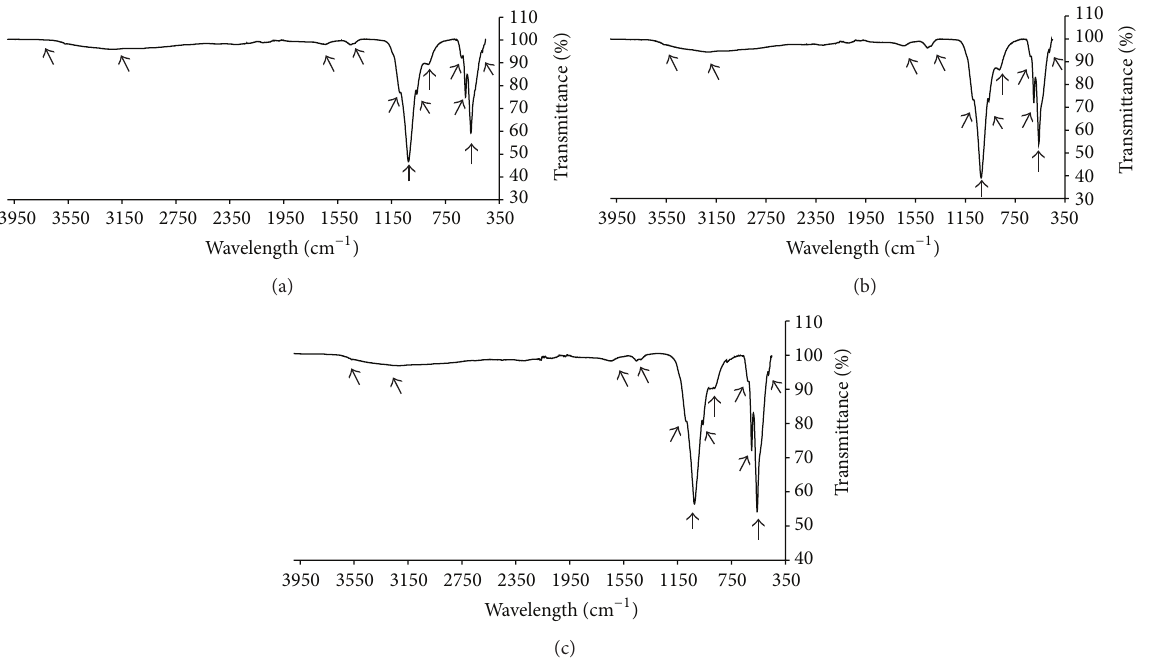
Figure 3: FTIR spectra of (a) dHA-A900, (b) cHA-900, and (c)